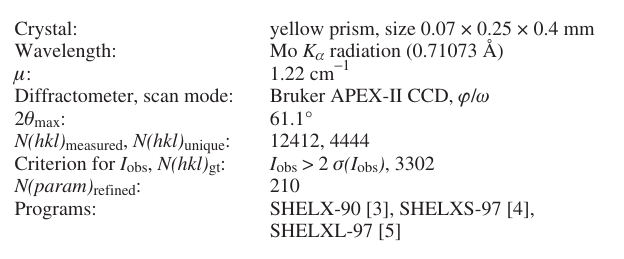
Table 1. Data collection and handling.